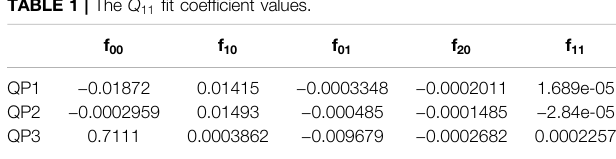
TABLE 1 | The Q 11 fi t coef fi cient